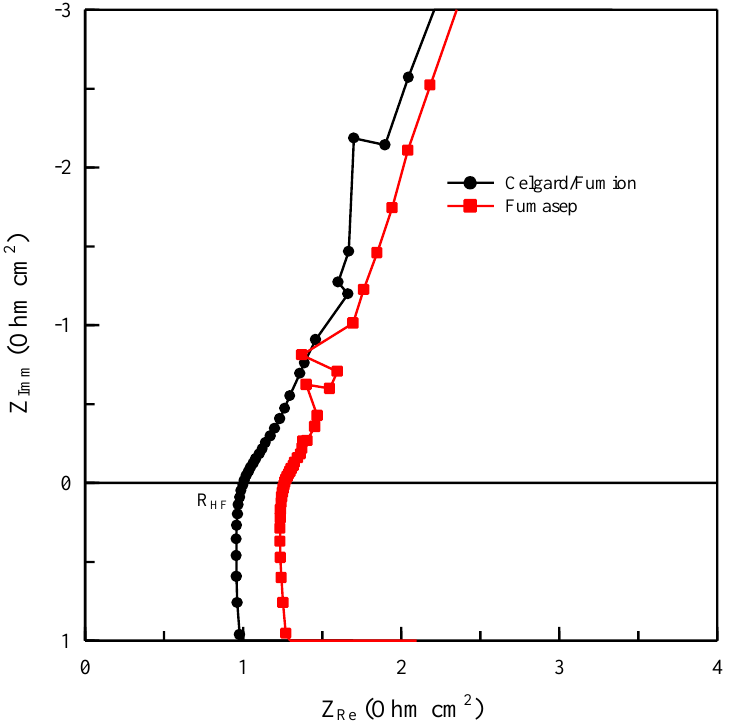
Figure 11. Nyquist plot for cell with Fumasep and Celgard/Fumion membranes at 25°and OCP (in electrochemical impedance spectroscopy — EIS).